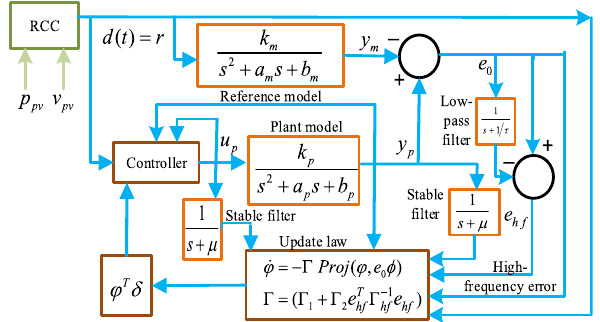
Figure 9. Architecture of 2nd-level of MPPT control (Novel HFLAG-MRAC